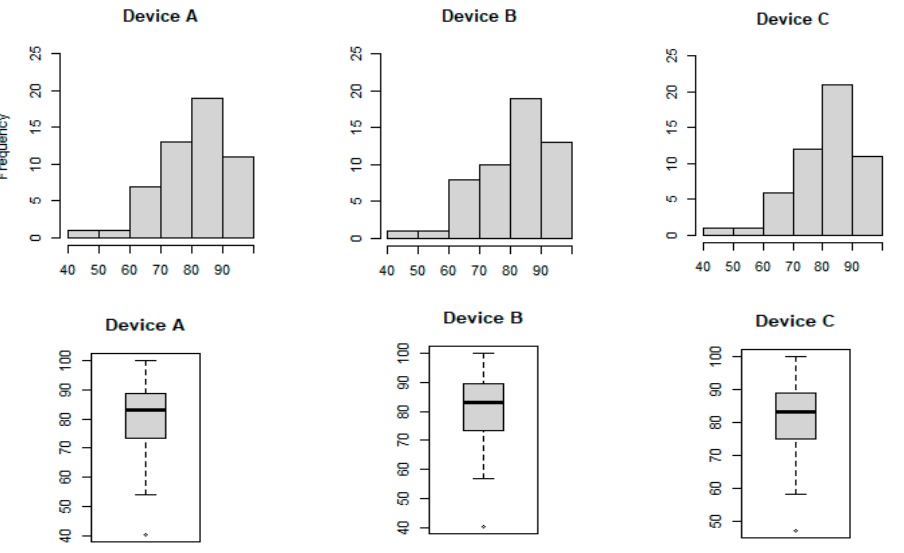
Figure 18. Histograms ( top row ) and boxplots ( bottom row ) of usability indexes—devices A, B, and C.